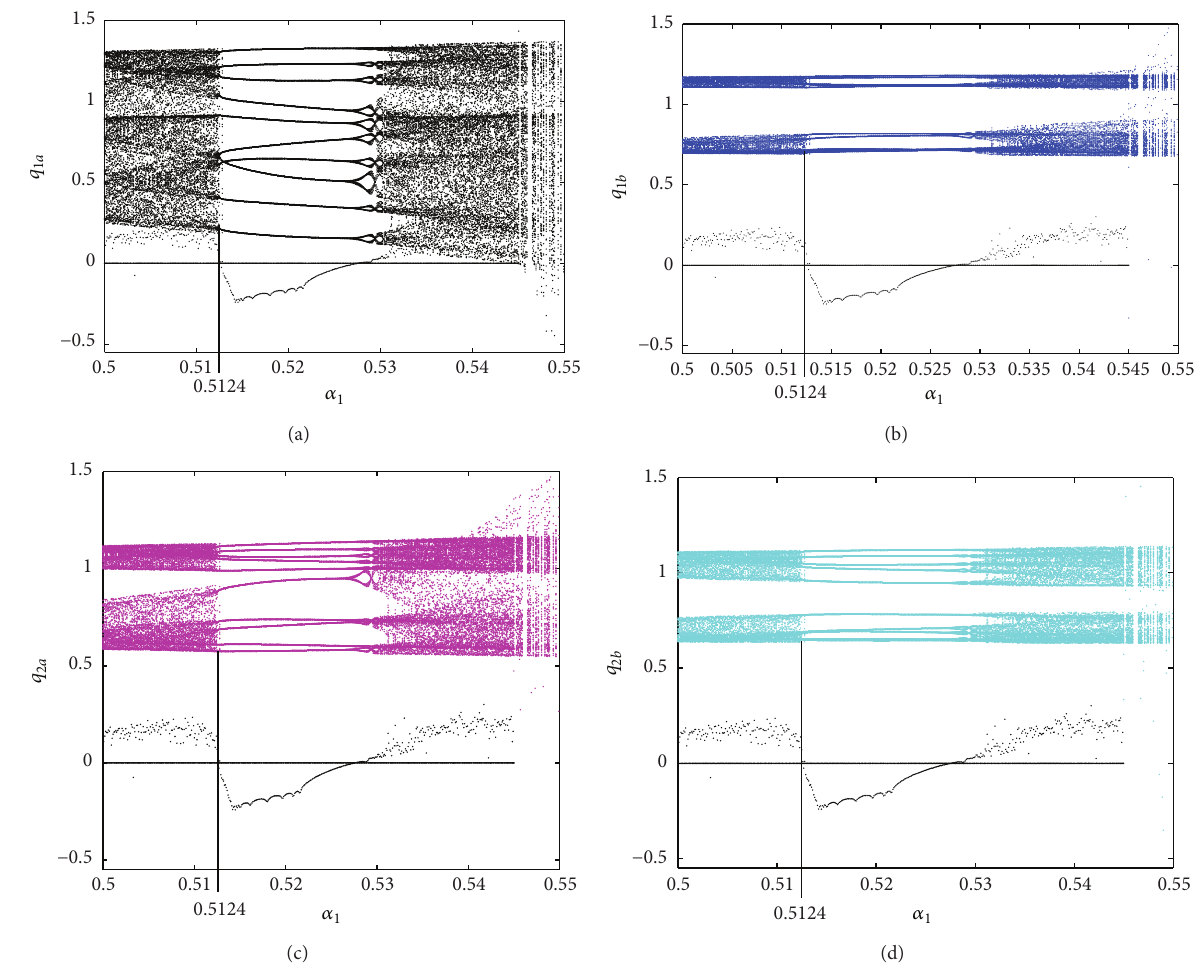
Figure 3: The enlarged drawing of tangential bifurcation and the maximum Lyapunov exponent.